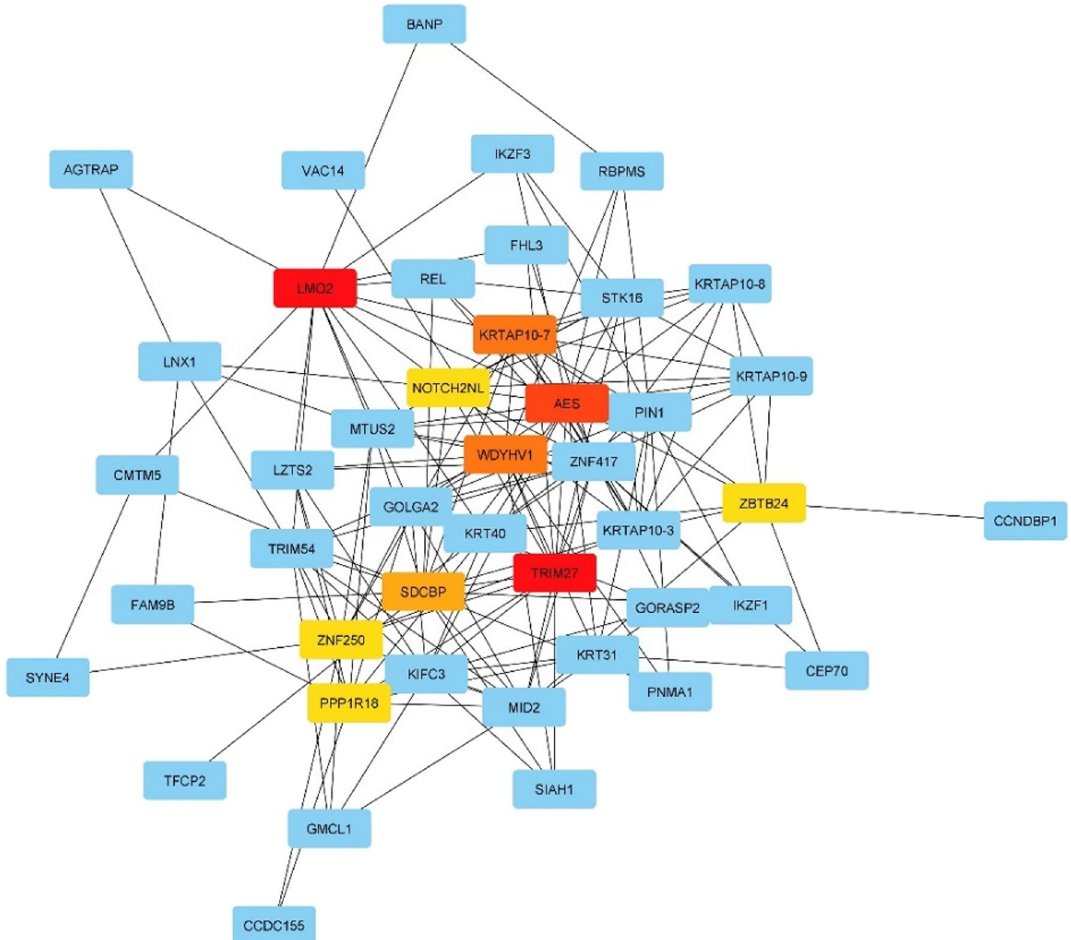
Fig. 4 The Cytoscape plugin cytohubba was used to identify the top hub nodes using the bottleneck method. Hub nodes in an enrichment analysis network study of their target genes. A colour-coded systems used to denote them from highly necessary (red) to necessary hub nodes